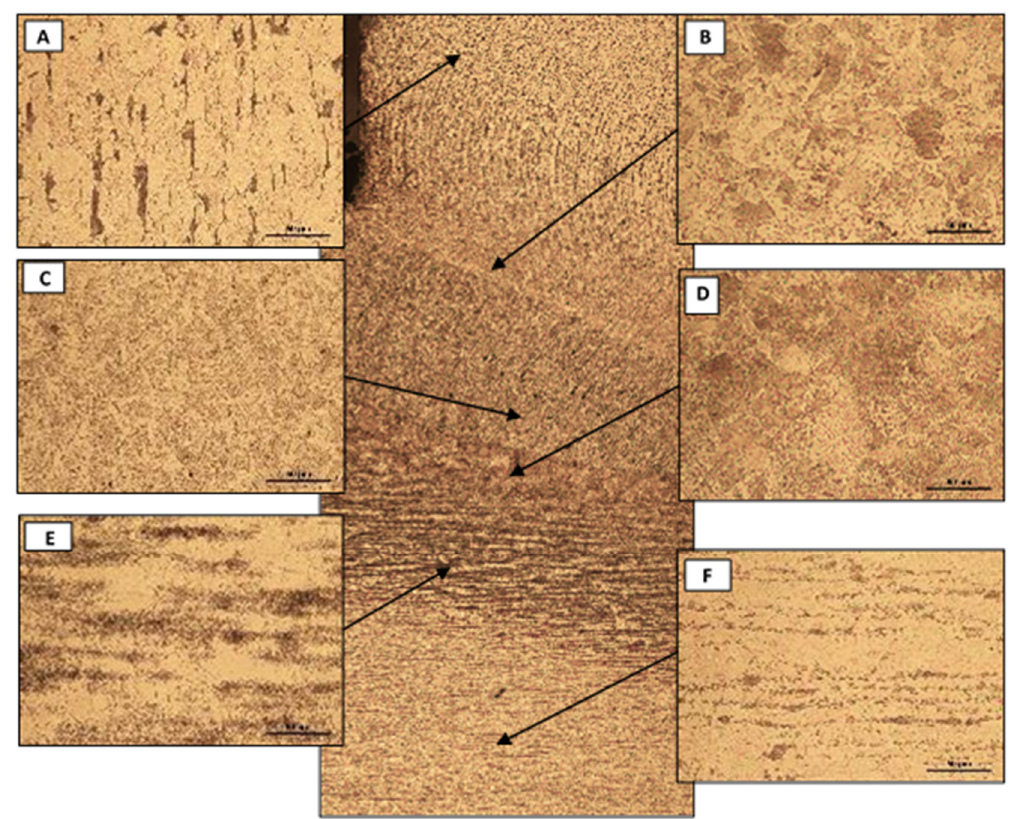
Figure 6. Micrographs of the T8 M20 4.8 welded stud. ( A ) unaffected base material of stud; ( B – D ) different ferrite and bainite microstructure; ( E ) ferrite and perlite; ( F ) unaffected base material of tube